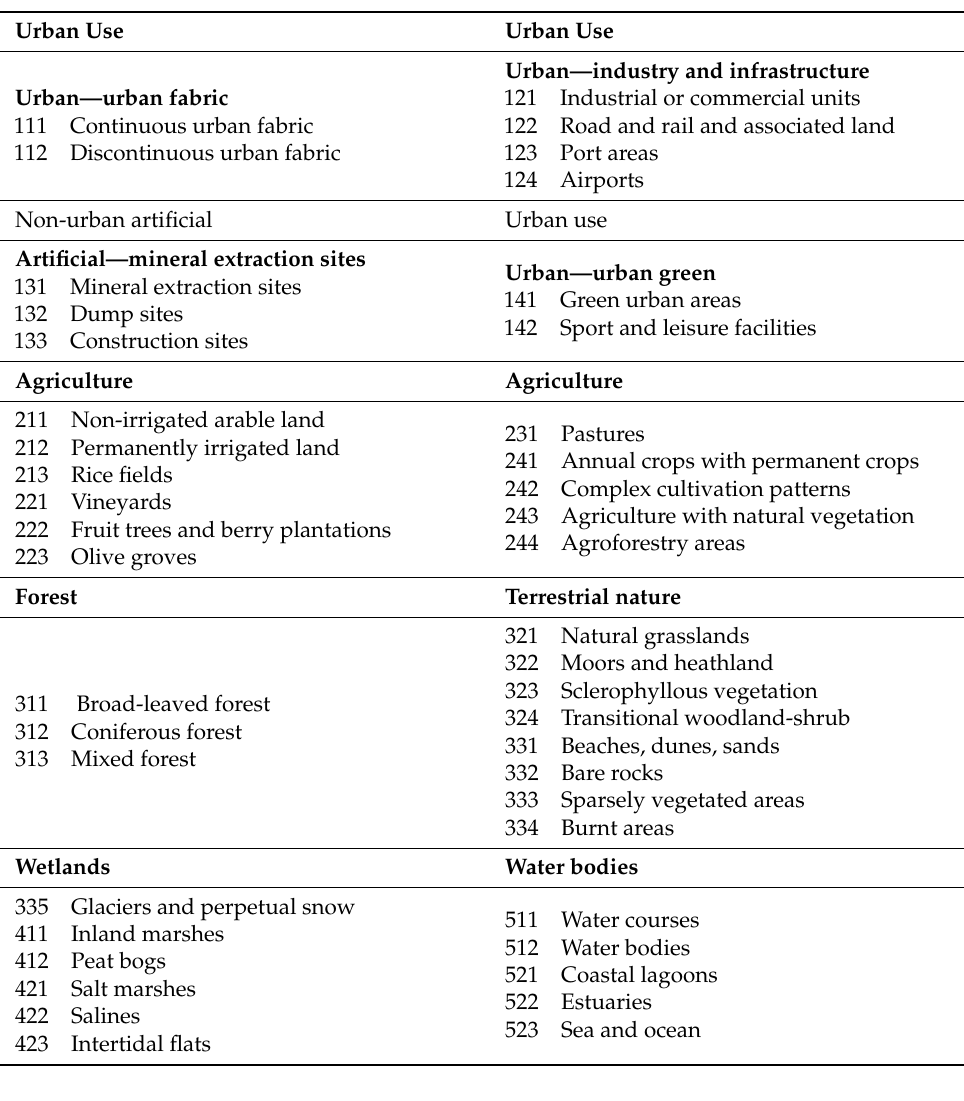
Table 2. Corine Land Cover Classes and their aggregation.